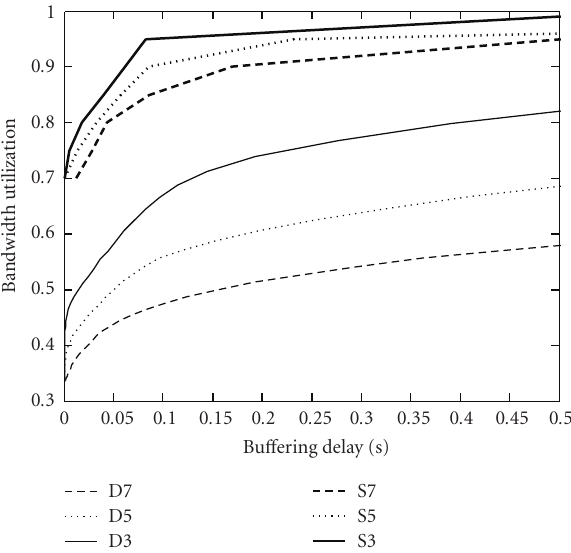
Figure 15: Bandwidth utilization versus bu ff ering delay for Stat- Mux and DetMux in low-delay operating